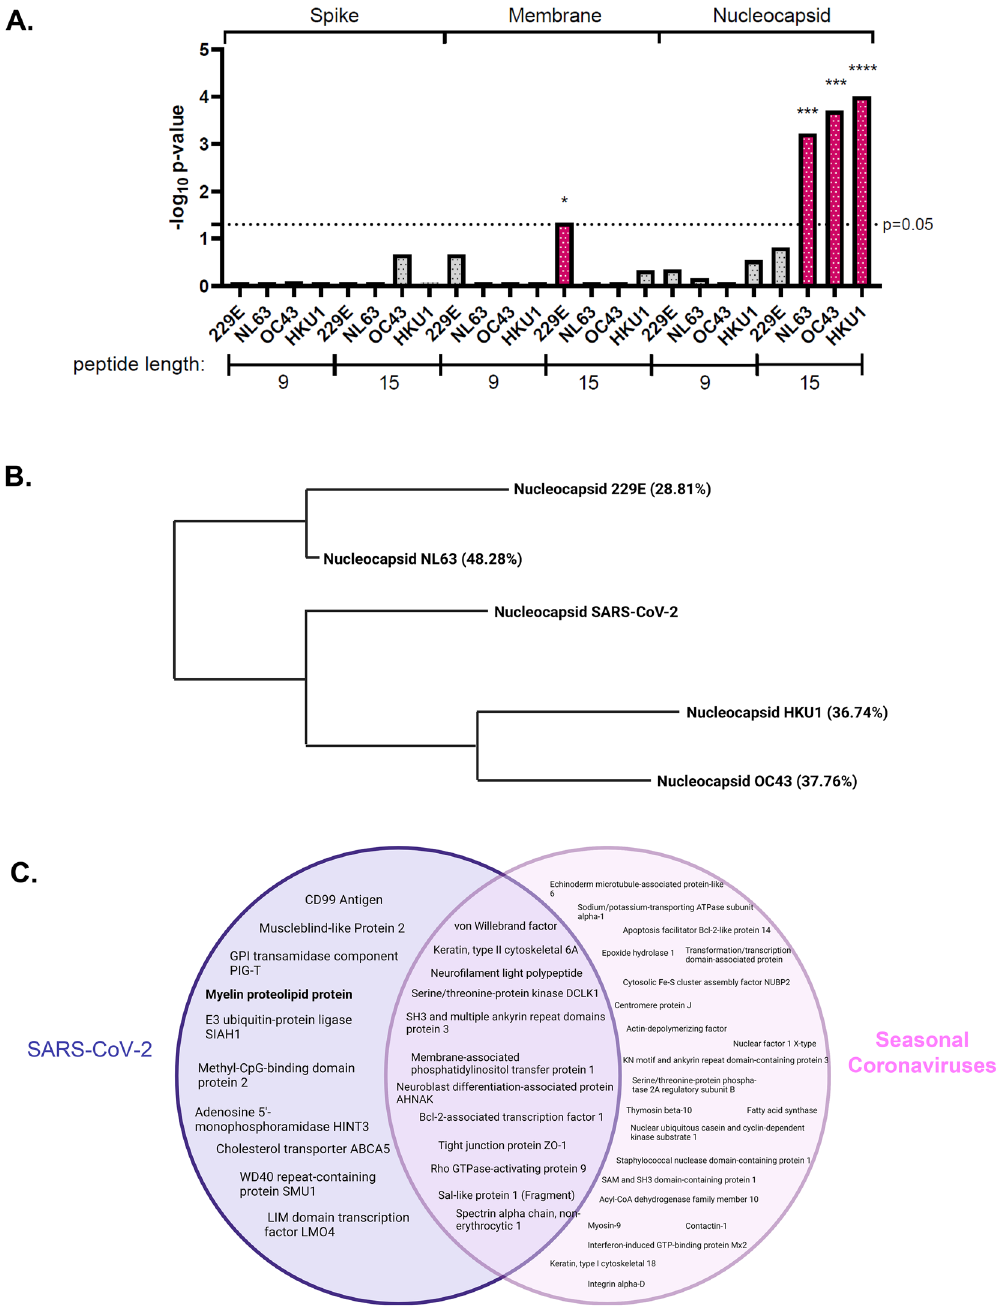
Figure 4. Nucleocapsid of seasonal coronaviruses show homology with MS-associated proteins, but only SARS- CoV-2 overlaps with PLP. ( A ) PEPMatch homology analysis was conducted as in Fig. 1 using spike, membrane, and nucleocapsid proteins from seasonal coronaviruses 229E, NL63, OC43, and HKU1. ( B ) BLASTp analysis was conducted to determine overall percent identity of seasonal coronavirus nucleocapsid proteins against SARS-CoV-2 nucleocapsid. Shown is a representation of the BLASTp homology output, with percent identity to SARS-CoV-2 nucleocapsid in parentheses. ( C ) PEPMatch-predicted proteins sharing homology with SARS- CoV-2 (left) and seasonal coronaviruses (right) were assessed for overlap using a Venn